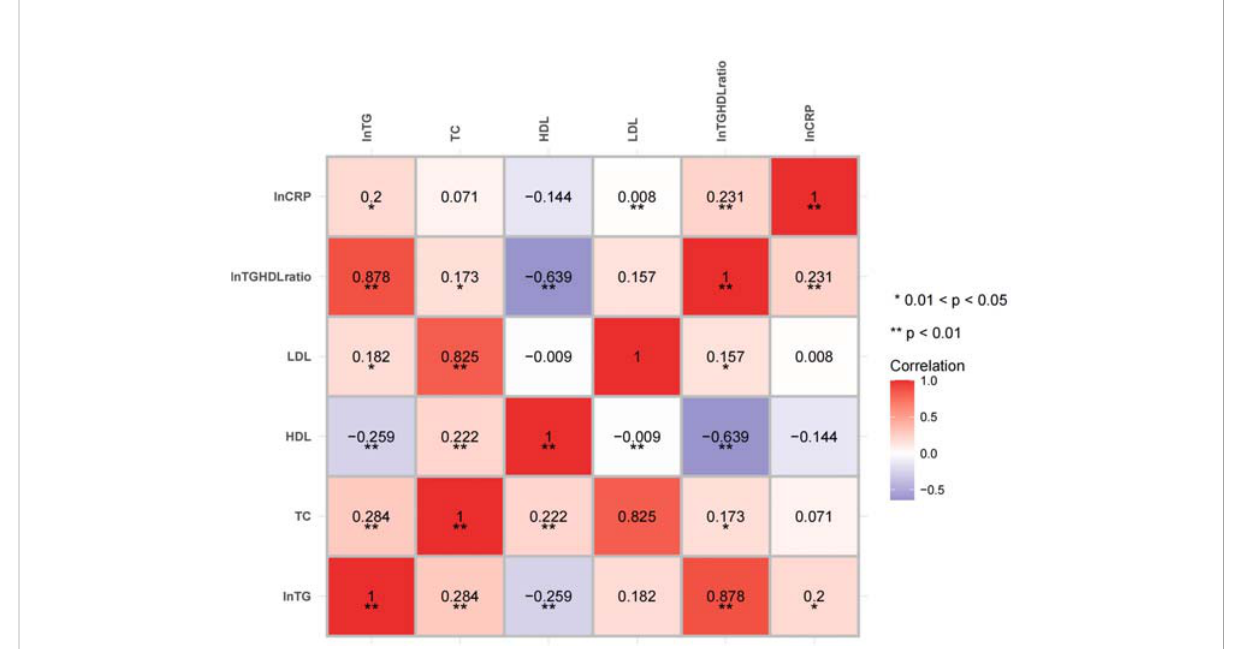
FIGURE 2 Heatmap of the correlation of the lipid pro fi les and in fl ammation marker after adjusting for glycated hemoglobin A1c (HbA1c). The correlations between the lipid pro fi les and the high-sensitivity C-reactive protein (hsCRP) levels were adjusted for age, sex, and HbA1c. Red and blue indicate a positive and a negative association, respectively. Color intensity represents the strength of the correlation. *0.01 < p < 0.05; ** p <